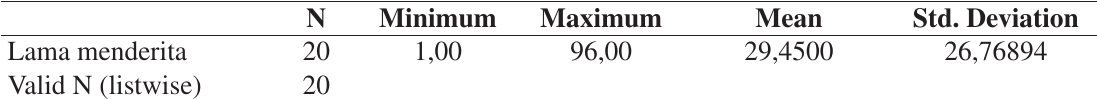
Tabel 1. Karakteristik responden berasarkan lama menderita HIV N Minimum Maximum Mean Std. Deviation Lama